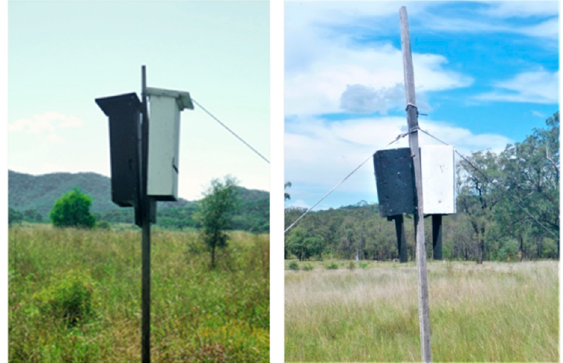
Figure 1. Paired plywood design ( left ) and paired wood-cement design ( right ) installed on poles about 1.5 m above ground.